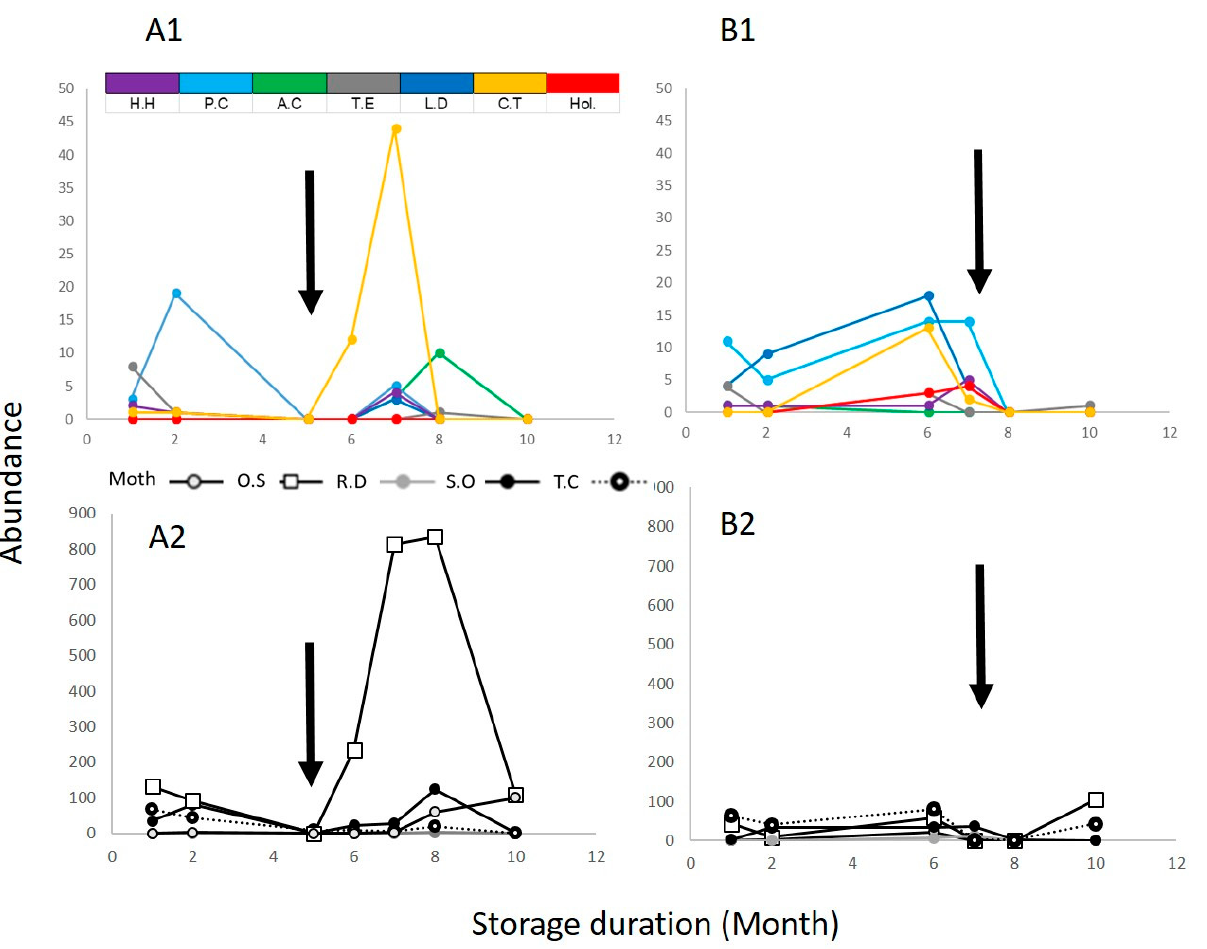
Figure 2. Abundance of ( 1 ) parasitoid wasps and ( 2 ) insect pests at ( A ) the Med. site and ( B ) the Ar. site. Arrows indicate time of exposure to phosphine. OS— Oryzaephilus surinamensis ; SO— Sitophilus oryzae ; TC— Tribolium castaneum ; RD— Rhyzopertha dominica ; Moth— Plodia interpunctella and Ephestia cautella. Wasps: CT— Cephalonomia tarsalis , Holepyris sp., HH— Habrobracon hebetor , LD— Lariophagus distinguendus , PC— Pteromalus cerealellae , TE— Theocolax elegans , AC— Anisopteromalus calandrae .